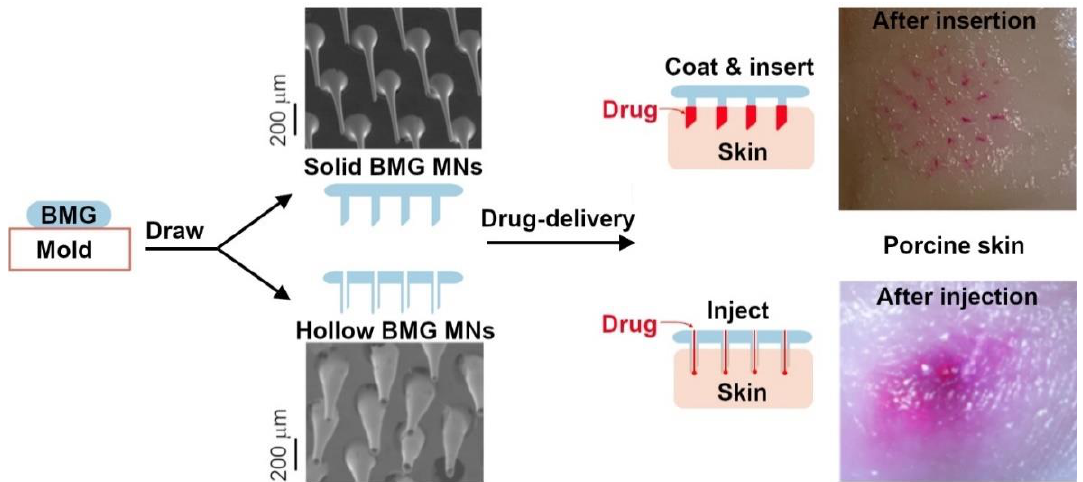
Figure 7. Fabrication of Pt-BMG microneedles (MNs) by thermoplastic drawing and their use in transdermal drug delivery. Solid BMG MNs are coated with drug and inserted in skin. Hollow BMG MNs inject the drug through pressure driven flow. The images of porcine skin show the capability of solid and hollow BMG MNs in drug delivery.